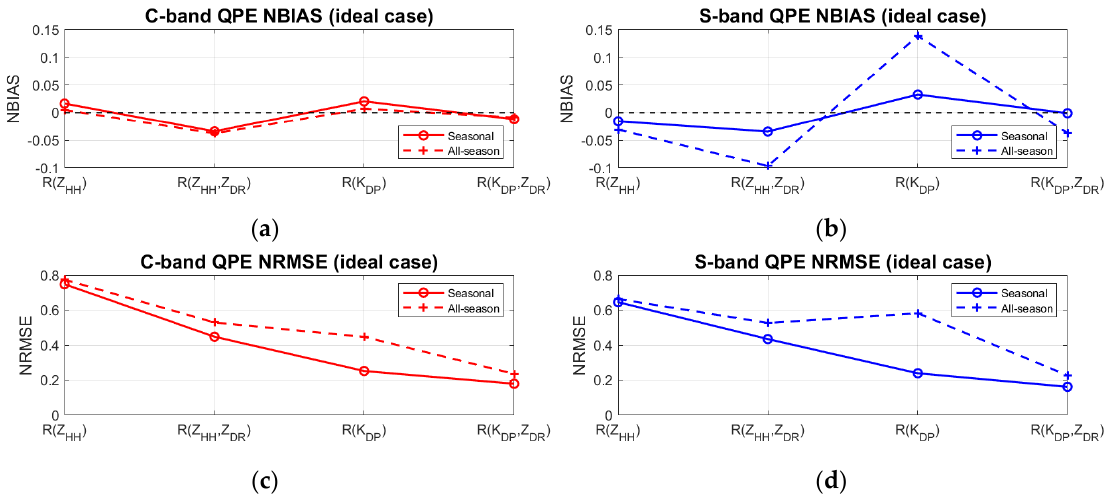
Figure 4. The normalized bias (NBIAS) of estimated rainfall rates using seasonal (solid lines) and all-season (dashed lines) coefficients at ( a ) C-band and ( b ) S-band. ( c ) and ( d ) are the same but for the normalized root mean square error (NRMSE). The estimated rainfall rates are derived from the RSD-simulated radar variables and compared to RSD-derived rainfall rates for the theoretical verification.